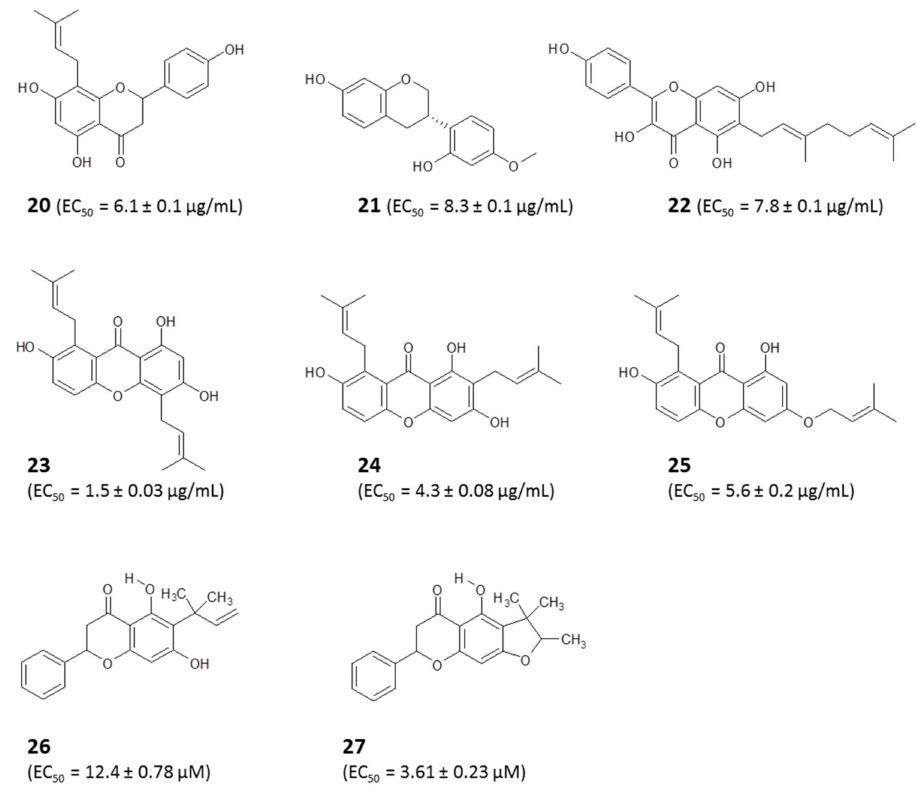
Figure 4. Antitrypanosomal compounds from Nigerian propolis. EC 50 values are from Omar et al., 2016, 2017